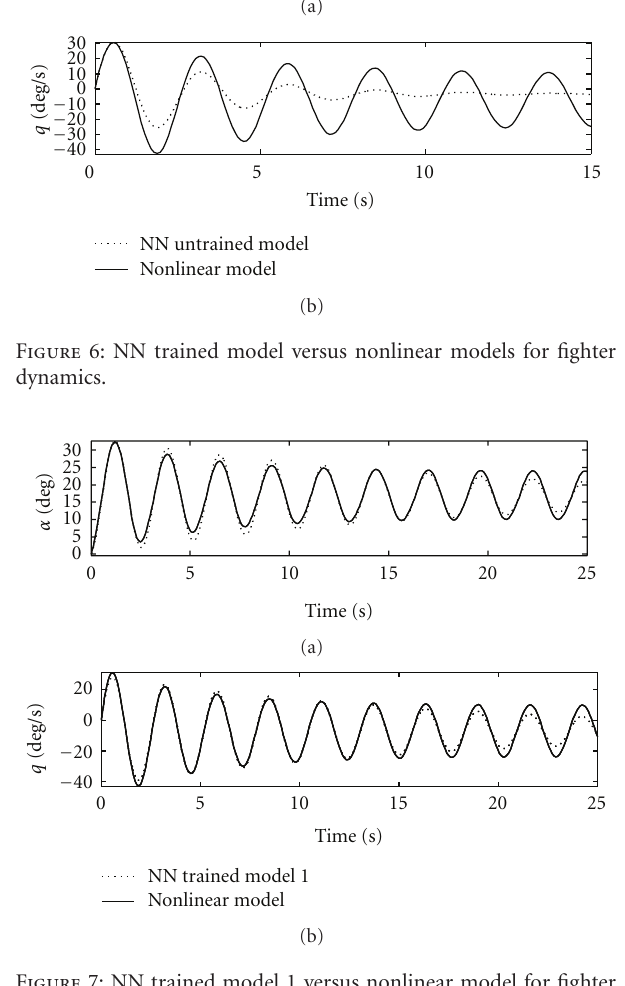
Figure 7: NN trained model 1 versus nonlinear model for fighter